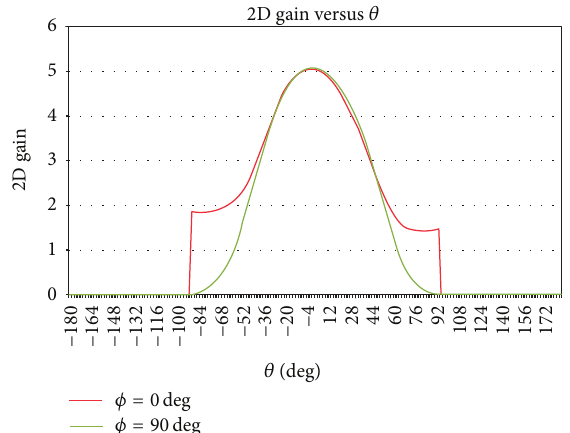
Figure 13: 2D gain of the CRA for the first iteration at 3.04 GHz.